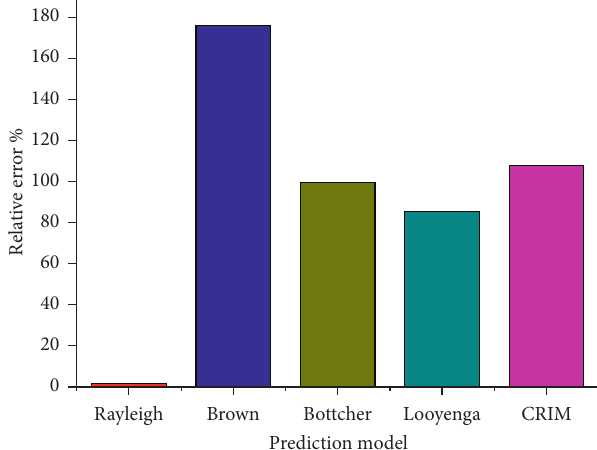
Figure 6: Relative error between prediction